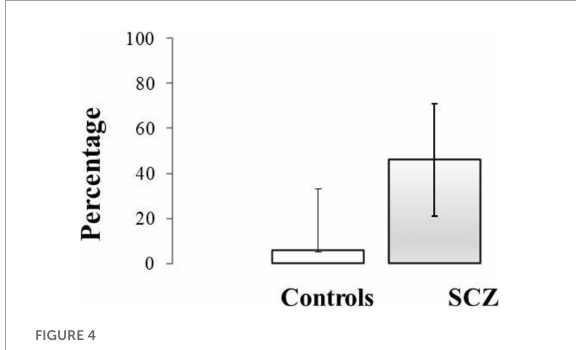
FIGURE4 The 95% confidence intervals (CIs) for the proportion of control participants and SCZ with variability ( σ ◦ ) greater than 2SD of the control mean value.